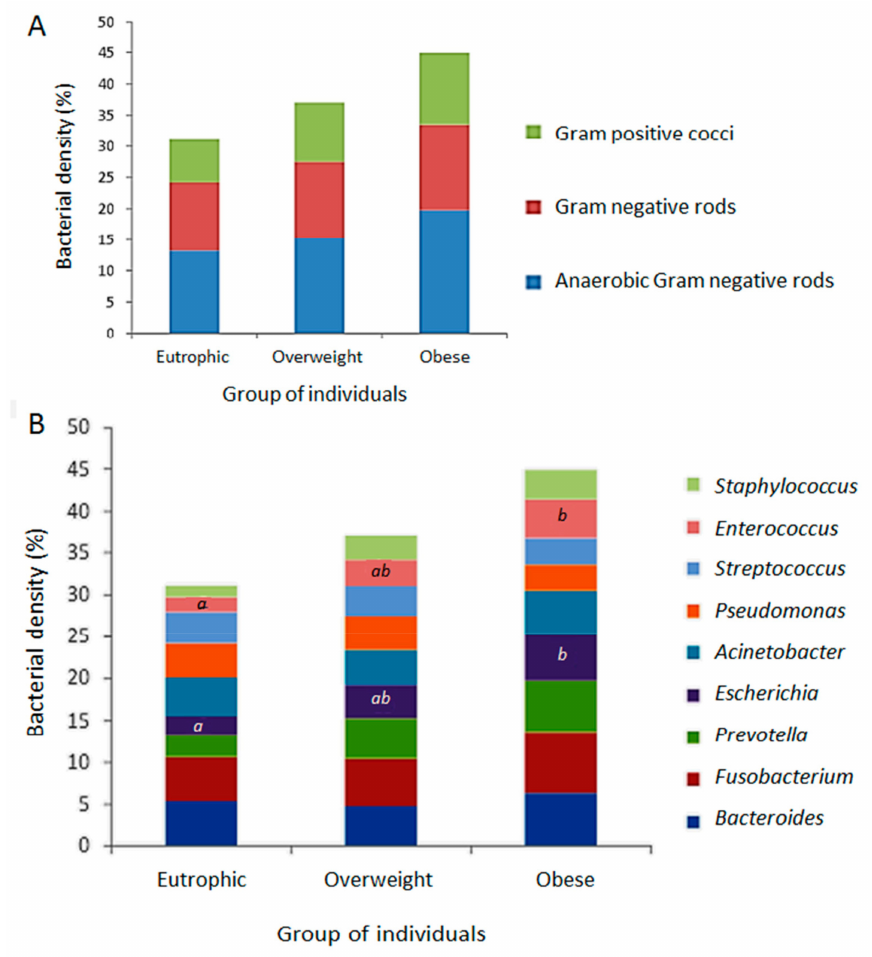
Figure 3. Relative density of the bacterial groups associated to the positive screening of antimicrobial resistance genetic markers (ARG), determined by fluorescence in situ hybridization (FISH) from the faecal metagenomes of eutrophic, overweight and obese individuals. ( A ) Quantitative evaluation by clustering different bacterial groups according to the hybridization probes available and relevance of microorganisms: anaerobic Gram-negative rods ( Fusobacterium spp., Prevotella spp., Bacteroides spp.); Gram-negative rods ( E. coli , Acinetobacter spp., Pseudomonas spp.); Gram-positive cocci ( Staphylococcus spp., Enterococcus spp., Streptococcus spp.). ( B ) Distribution of evaluated bacterial groups among eutrophic overweight and obese individuals. Captions a , b , and * indicate statistically significant results ( p < 0.05). Odds ratio was calculated between the ARG and BMI, caloric intake, use of xenobiotics and artificial sweeteners. It was established as a cut-o ff parameter that at least 5 ARG corresponded to approximately 10% of all markers assessed. There was a positive correlation between the detection of ARG in the faecal metagenome of obese individuals and all the evaluated parameters (Table